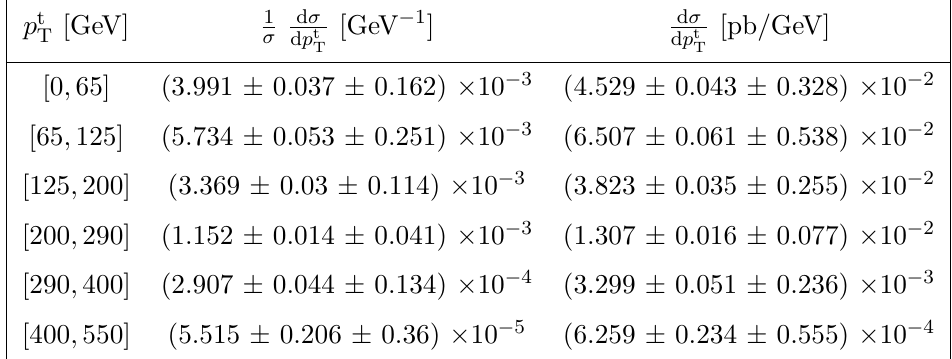
Table 15 . The measured di(cid:11)erential cross section and bin boundaries for each bin of the normalized and absolute measurements of the tt di(cid:11)erential cross section at particle level in the (cid:12)ducial phase space as a function of p t are tabulated. T